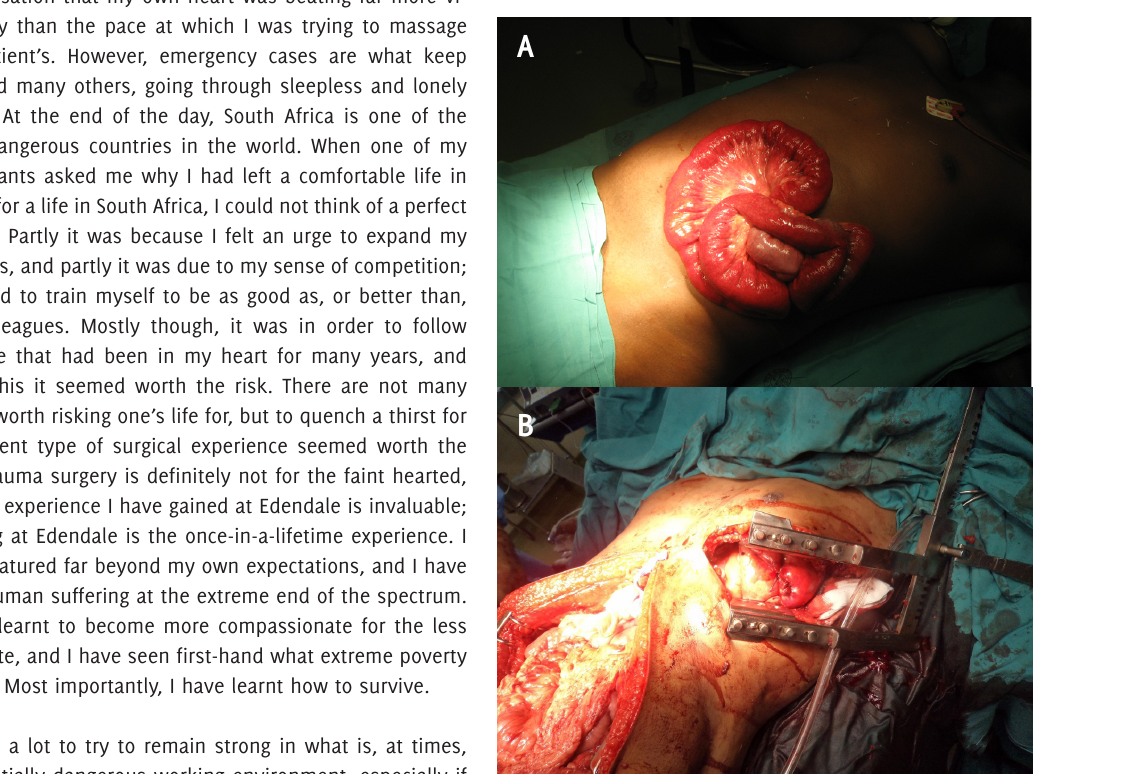
Figure 4. A: Patient with a stabbed abdomen, with bowel evisceration. B: Patient with multiple GSW (gunshot wound) to